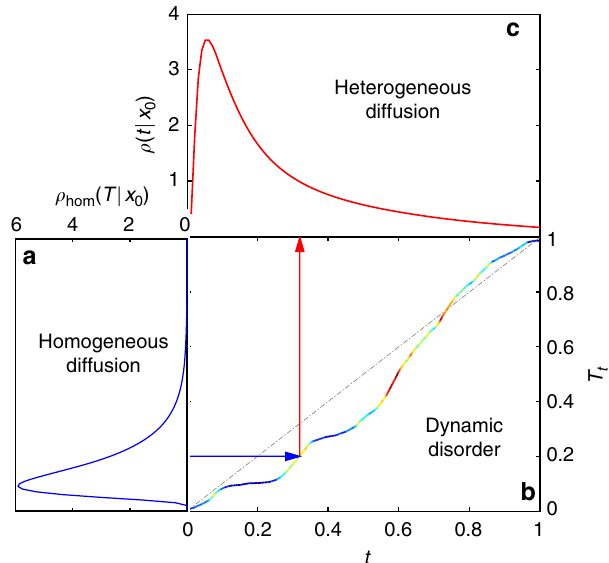
Fig. 3 Illustration of the subordination concept. The fi rst-passage time to the reactive target is understood as the moment of the fi rst crossing of a random barrier by the integrated diffusivity T t . a The geometric structure and reactive properties of the medium determine the probability density function ρ hom ( T | x 0 ) of the fi rst-passage time T to the reactive target by hom homogeneous diffusion. This FPT is the “ duration ” of a random Brownian path to the reactive target that sets the barrier to the integrated diffusivity T t (horizontal blue arrow). The randomness of such Brownian paths results from thermal fl uctuations. b Rapid rearrangements of the medium lead to a random realization of the “ internal time ” T t , obtained by integrating the stochastic diffusivity D t shown in Fig. 1c; colors are reproduced from that fi gure, ranging from dark blue (low diffusivity) to dark red (high diffusivity). The random moment t (shown by vertical red arrow) when T t crosses the random barrier T is the fi rst-passage time to the reactive target by hom heterogeneous diffusion. c The probability density ρ ( t | x 0 ) of this FPT is obtained by averaging the density q t ; T over the distribution of T hom ð Þ hom given by ρ hom ( T | x 0 ). The broadening of ρ ( t | x 0 ) is caused by superimposing two sources of randomness in heterogeneous diffusion: thermal fl uctuations (as in ρ T | x hom ( 0 )) and medium rearrangements. Arbitrary units are used for this illustrative